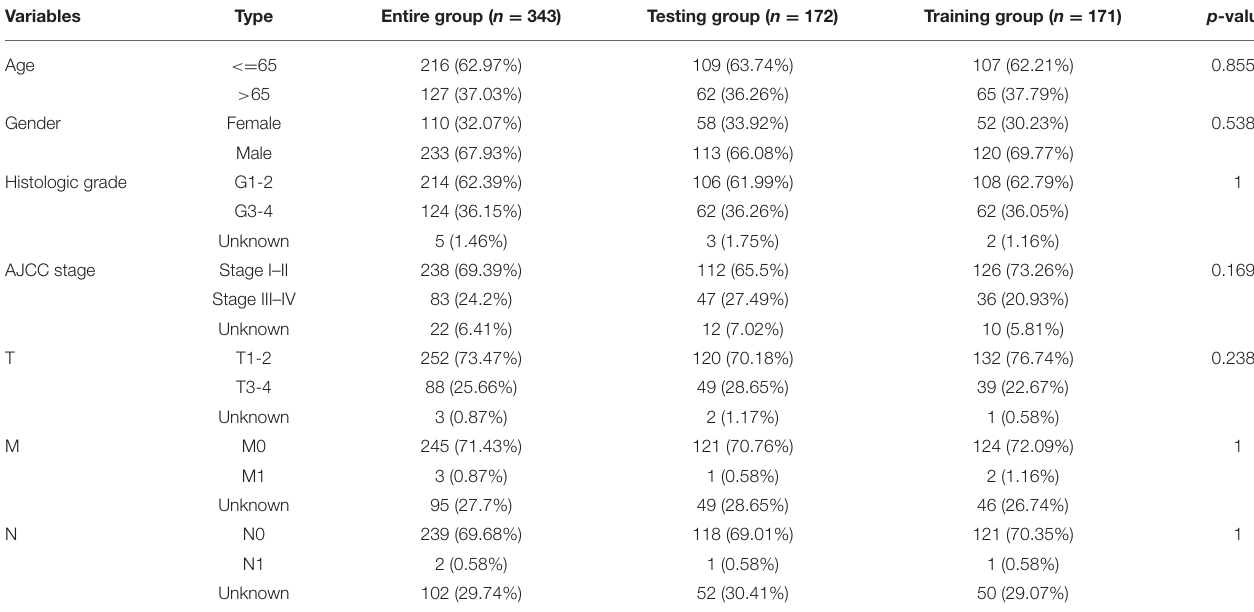
TABLE 1 | Clinical information of the 343 patients with liver cancer.